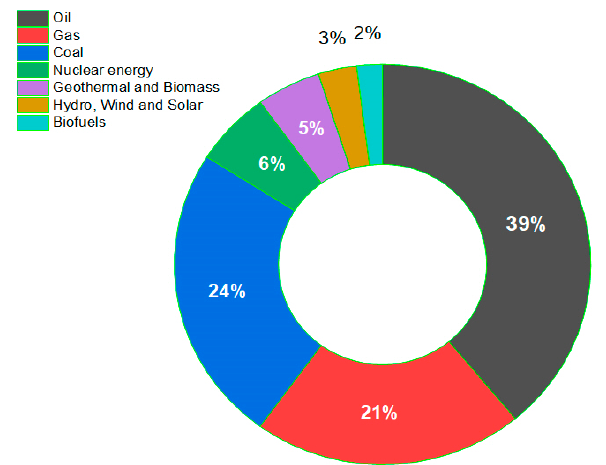
Figure 2. Percentage of energy consumption of fuels .